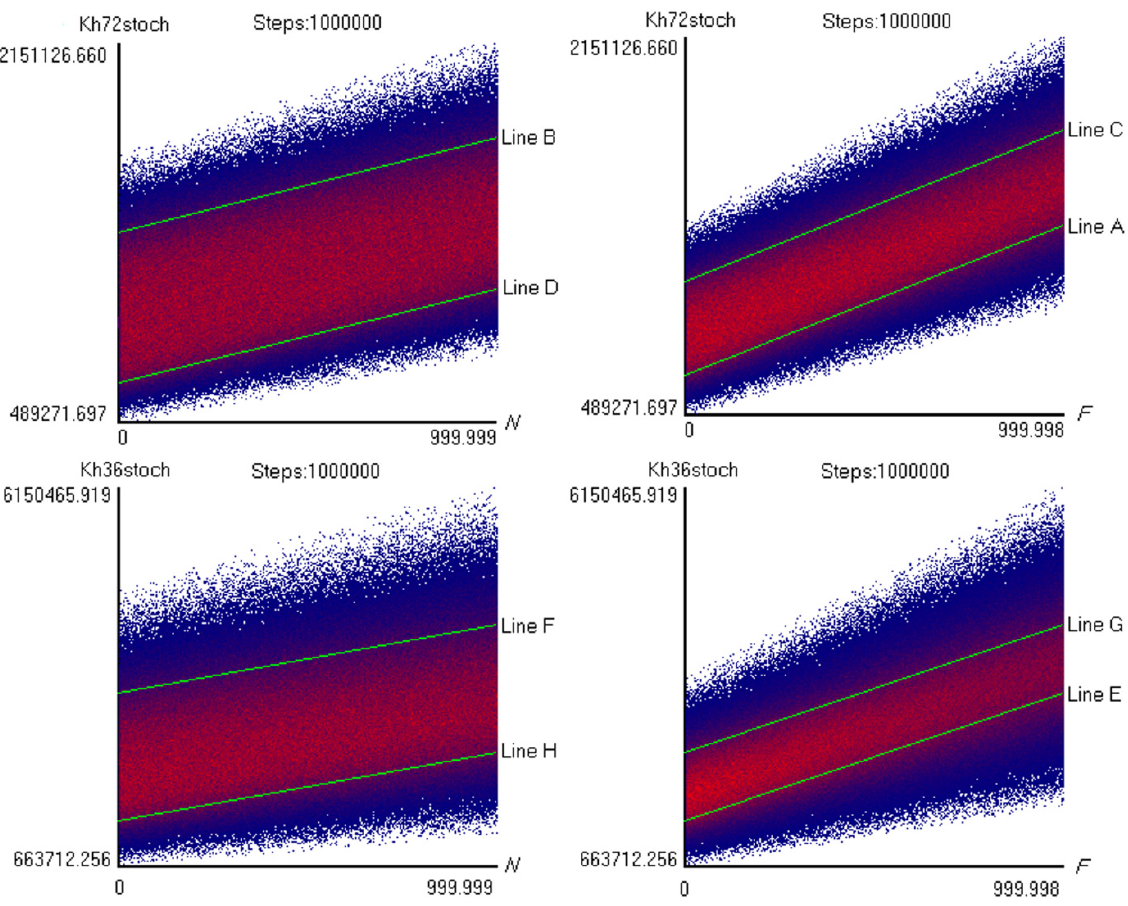
Figure 13. 2D histograms 𝐾 (cid:3035)(cid:2880)(cid:2875)(cid:2870)(cid:3046)(cid:3047)(cid:3042)(cid:3030)(cid:3035) /Nm − 3 / ( top ) and 𝐾 (cid:3035)(cid:2880)(cid:2871)(cid:2874)(cid:3046)(cid:3047)(cid:3042)(cid:3030)(cid:3035) /Nm − 3 / ( bottom ). Figure 13. 2D histograms K h = 72 stoch /Nm − 3 / ( top ) and K h = 36 stoch /Nm − 3 / ( bottom